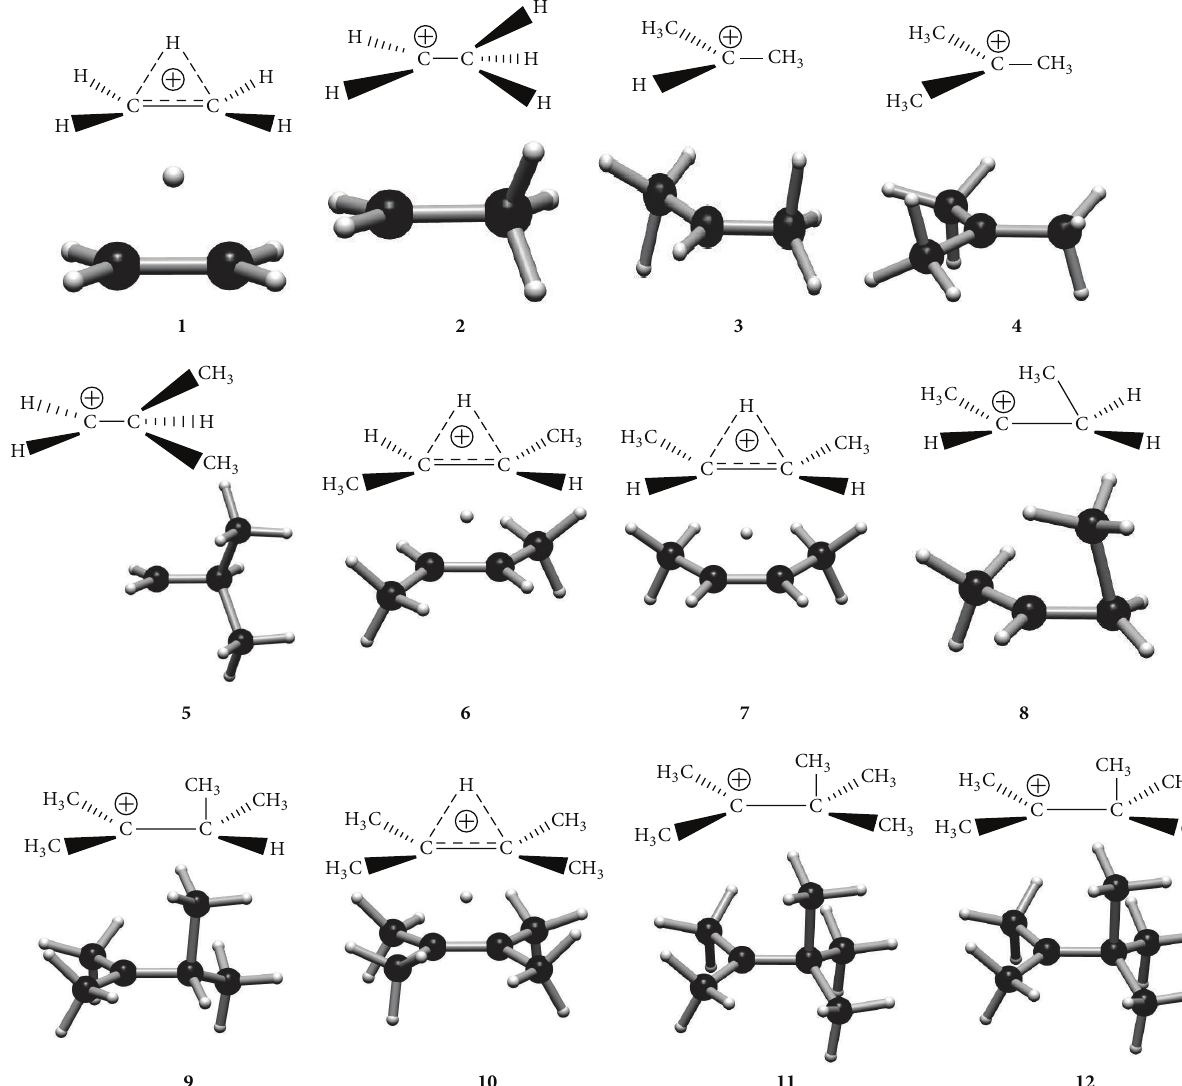
Figure 1: Optimized structures of alkyl-substituted ethyl cations at MP2/6-311+G(d,p) level of